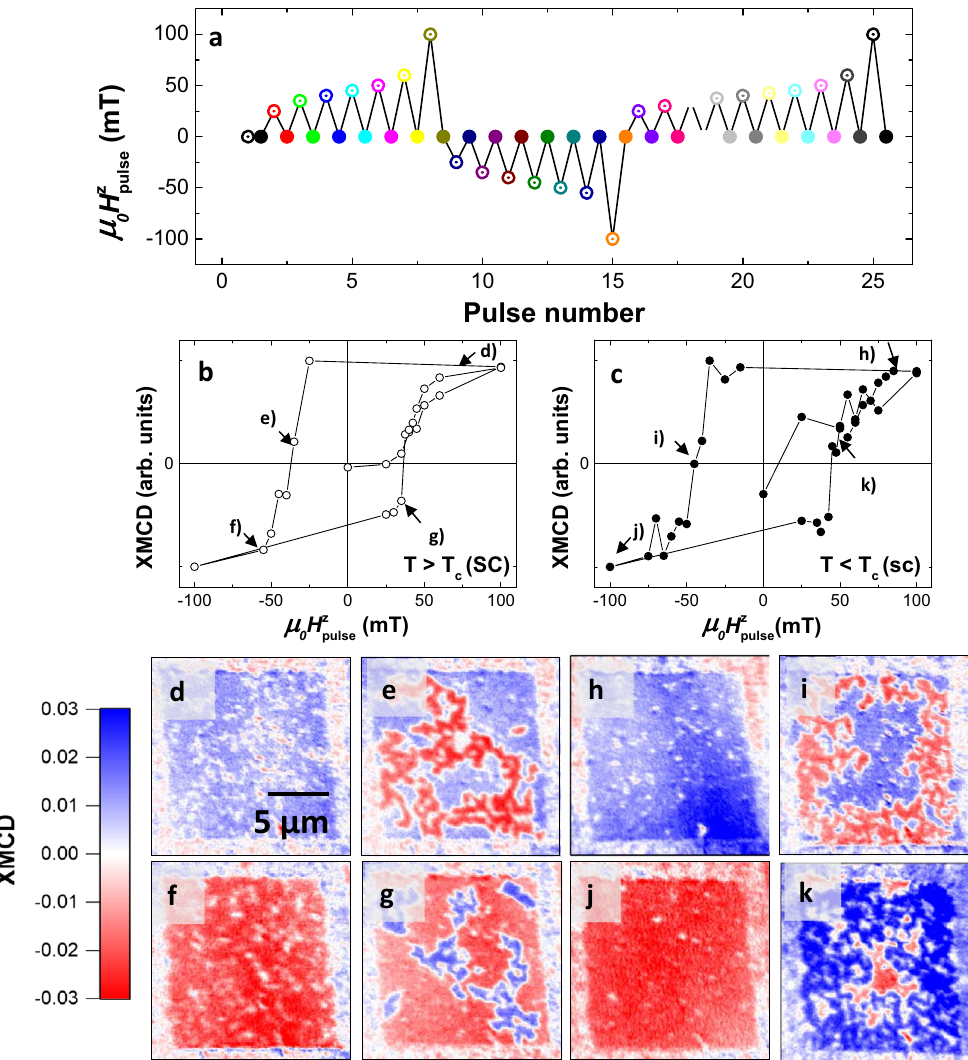
Figure 2. ( a ) Sketch of the magnetic pulse history followed at 120 K. XMCD imaging takes always place after pulse end (full dots). ( b,c ) XMCD averaged over the whole square structure vs H z pulse within the normal (T > T C , ( b )) and superconducting (T < T C , ( c )) state of the YBCO square. ( d–g ) XMCD images at selected H z pulse (see arrows in panel b) for T > T C . ( h–k ) XMCD images at selected H z pulse (see arrows in ( c )) for T < T C . Above T C domain nucleation takes place at random positions while at for T < T C it is confined at